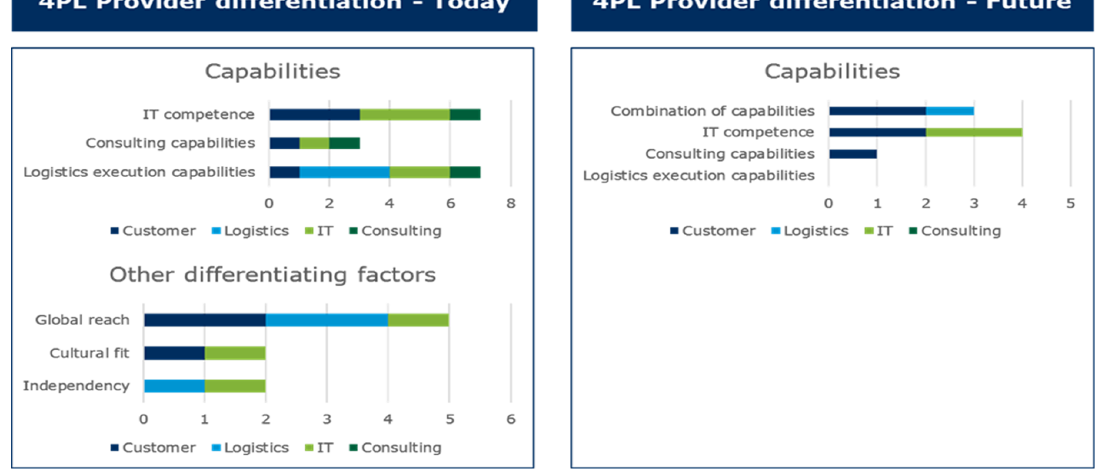
Figure 3. Comparison for 4PL provider differentiation: results of semi-structured interviews.